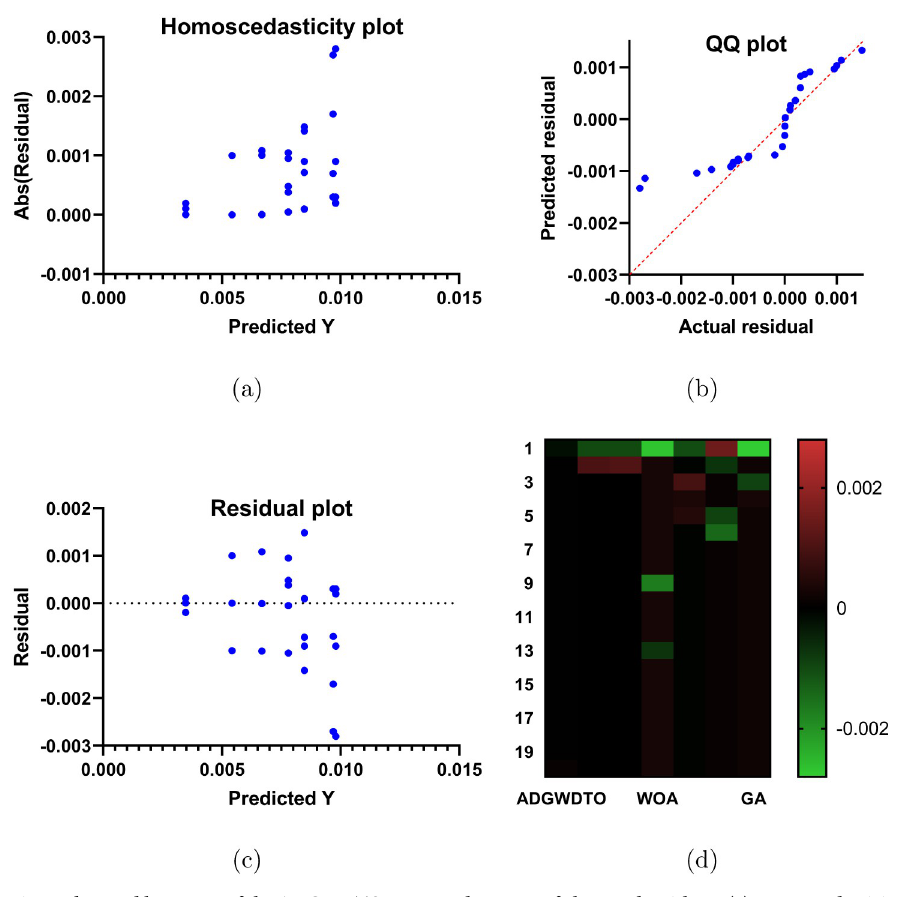
Fig 4. Plots and heat map of the ADGWDTO compared to state-of-the-art algorithms, (a) Homoscedasticity plot, (b) QQ plot, (c) Residual plot, and (d) Heat map.